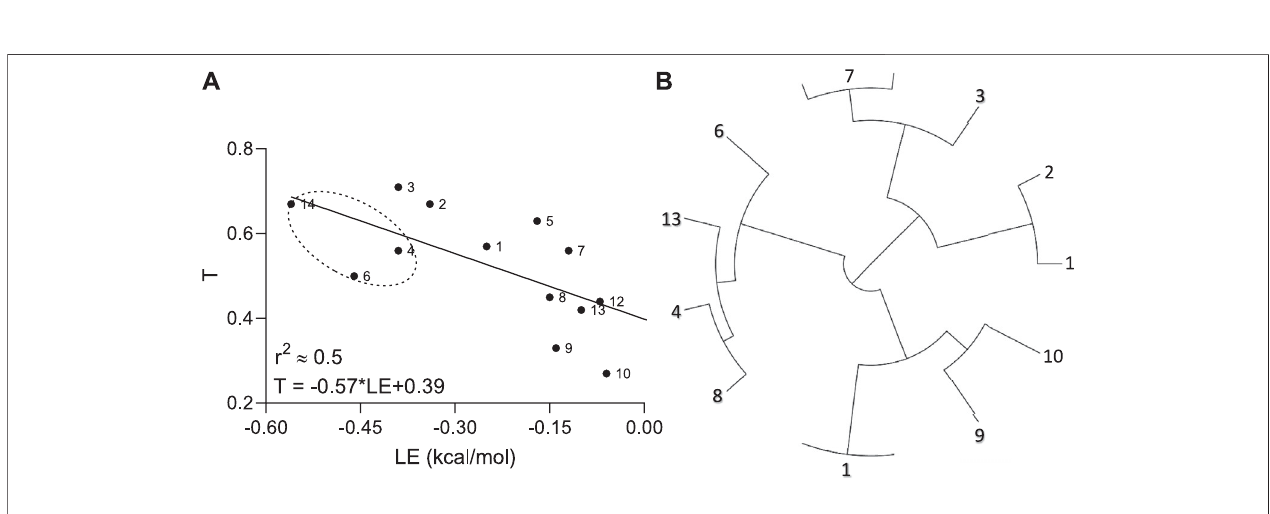
FIGURE 3 | Relationship (A) between Tanimoto similarity (T) and ligand ef fi ciency (LE) descriptors and tree visualization (B) of the hierarchical clustering based on structural similarities calculated for hit molecules ( n (cid:1) 13), containing propanesulfonic scaffold of TRA.